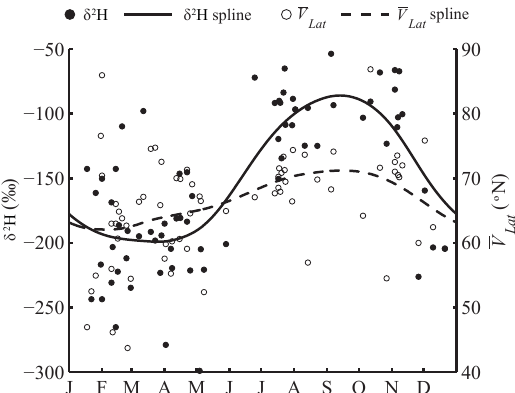
Figure 4. Measured δ 2 H of Barrow precipitation and mean lati- tude of the vapor source both exhibit an annual cycle and are in phase. The circles depict raw data, while curves are spline fits to the data. The spline fits have R 2 values of 0.60 and 0.19 for the δ 2 H and V Lat , respectively. For both datasets, the variability exhib- ited among events is of the same order of magnitude as the seasonal